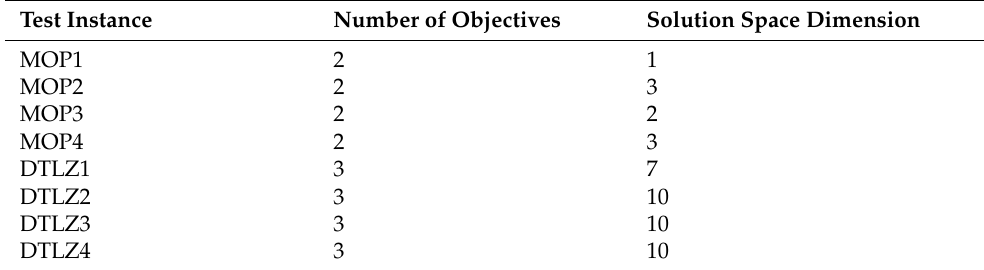
Table 1. Details of all test instances.